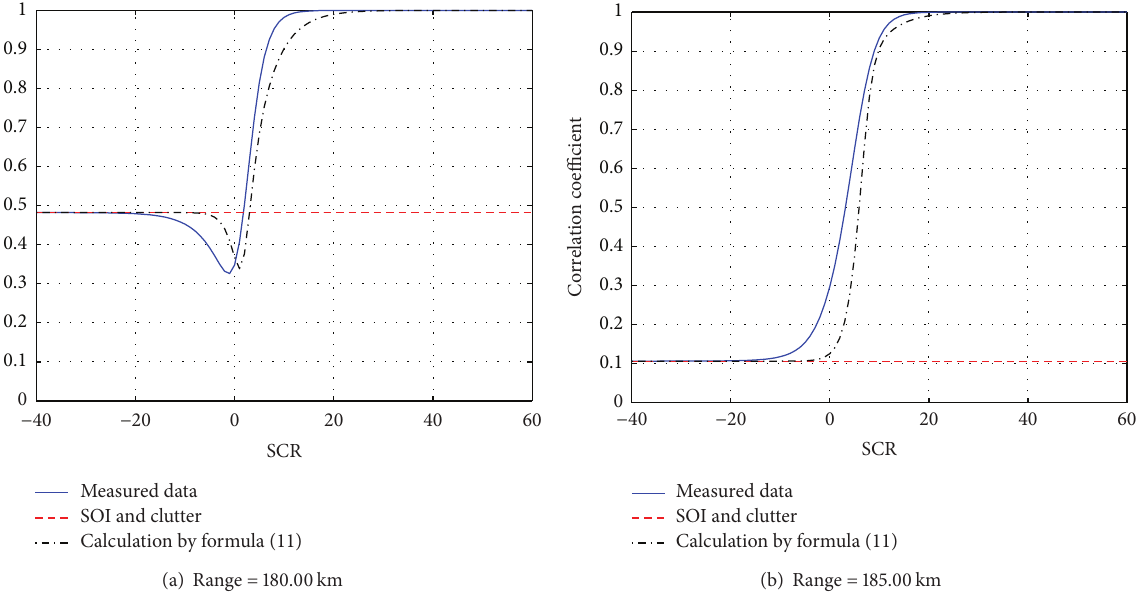
Figure 7: The relationship between correlation and SCR.